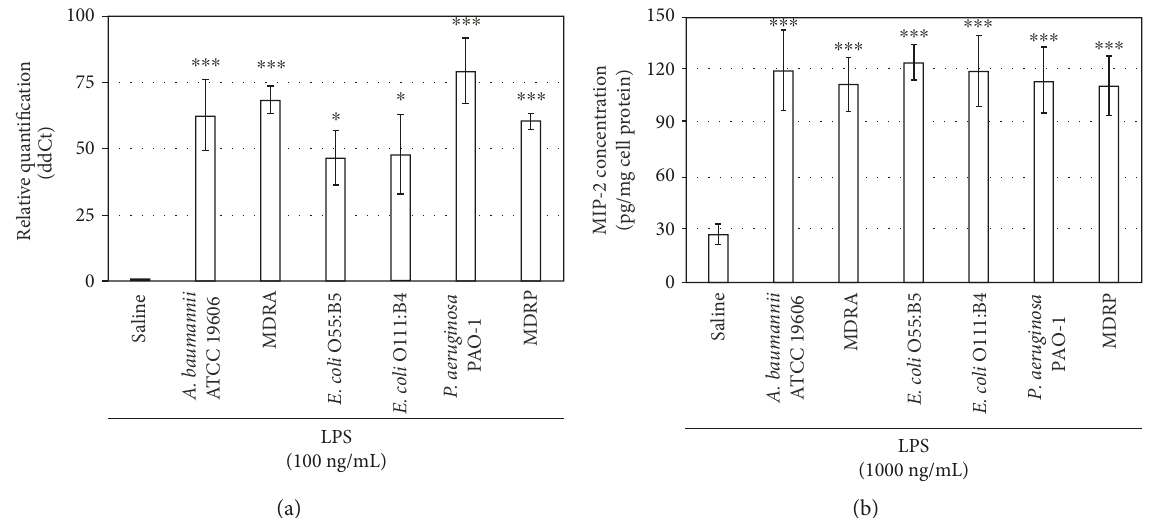
Figure 5: E ff ect of LPS prepared from six strains of gram-negative bacteria on MIP-2 expression in 3T3-L1 adipocytes. (a) Di ff erentiated adipocytes were incubated for 1h with 100ng/mL LPS prepared from six strains of gram-negative bacteria, including A. baumannii ATCC 19606, MDRA, E. coli O55:B5, E. coli O111:B4, P. aeruginosa PAO1, and MDRP. The cells were then subjected to a real-time PCR analysis for MIP-2 expression. (b) Di ff erentiated adipocytes were incubated for 48 h in complete fresh medium containing 1000 ng/mL LPS prepared from six strains of gram-negative bacteria or saline, and the MIP-2 levels in the culture medium were measured by an ELISA. All experiments were performed in triplicates, and the results are presented as the mean ± SD. ∗ P < 0 05 ; ∗∗∗ P < 0 005 (compared to adipocytes without LPS